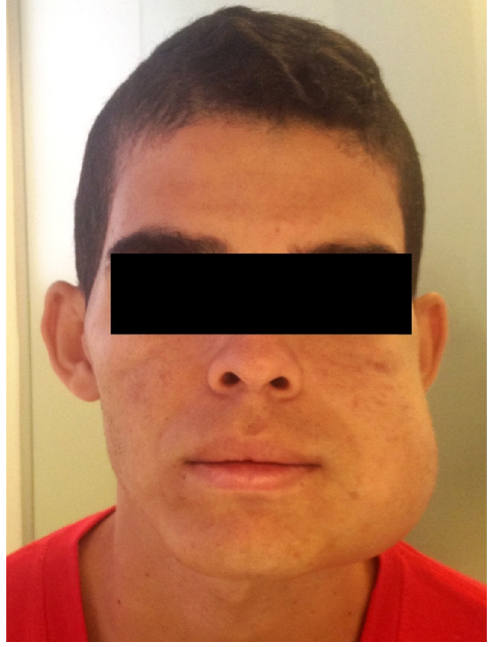
Figure 1 Clinical findings. Front view of the patient showing marked facial asymmetry.